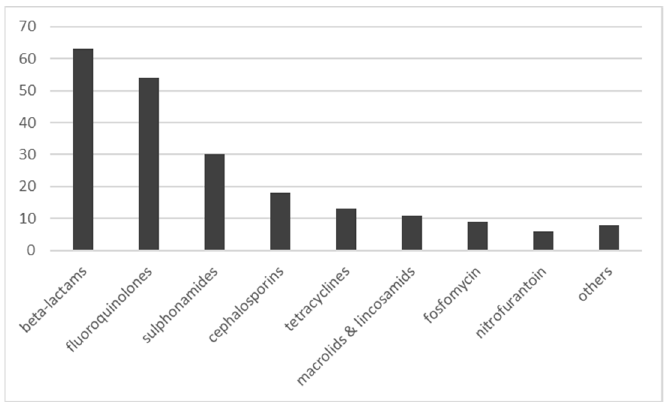
Figure 1. Systemic antimicrobial substances for the treatment of 212 health care associated